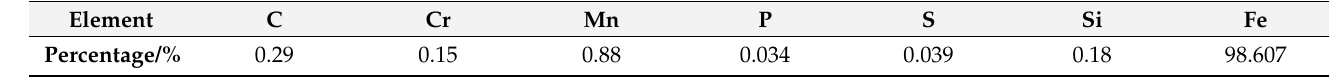
Table 1. The chemical composition of the used CS-alloy in corrosion